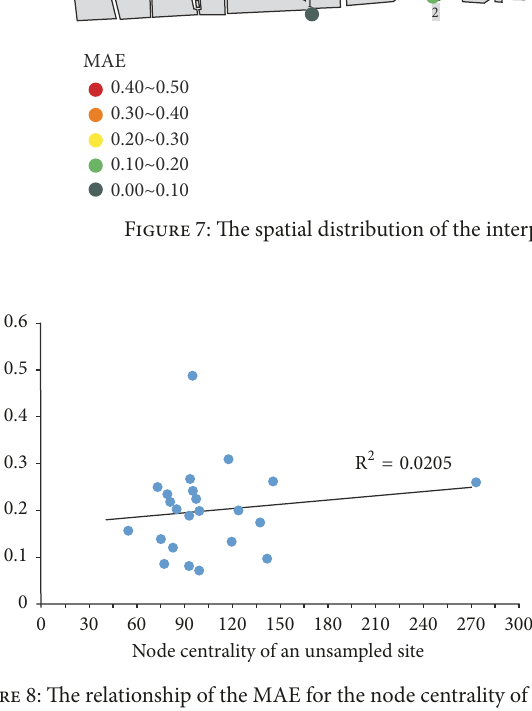
site60 90 120 150 180 210 240 270 3000 30 Node centrality of an unsampled Figure 8: The relationship of the MAE for the node centrality of an unsampled